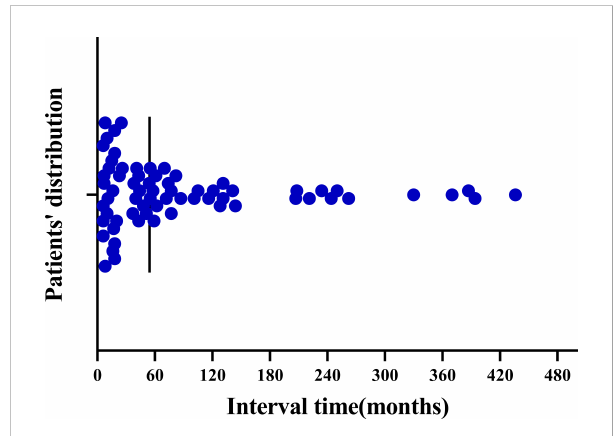
FIGURE 2 Distribution of time intervals between the development of metachronous second primary breast cancer in patients with primary non-breast microcalci fi cations are the main points of difference. As shown in Table 5, both SPBC and BM patients were more likely to show a solitary breast tumor. The difference is that patients with SPBC has a higher proportion of solitary breast tumors than BM patients (90.24% vs. 64.71%, p =0.01). Mammography was performed in 100 patients with SPBC and seven patients with BM. Microcalci fi cations were found in 75% (75/100) of the patients with SPBC, whereas in the BM group, only one patient with ovarian cancer reported the presence of microcalci fi cations (14.29%) ( p =0.002). All 17 patients with BM underwent imaging studies, and four patients were diagnosed with breast metastasis; however, up to 70.59% were diagnosed with primary breast cancer. It was challenging to distinguish between primary breast cancer and metastatic breast cancer on imaging.